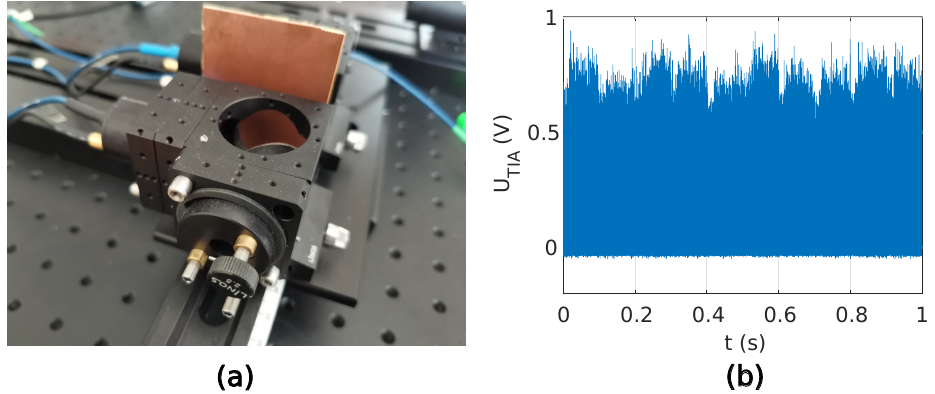
Figure 9. Experiment with obstructed THz beam path: ( a ) PCAs positioning with inserted copper plate, ( b ) section of the measured TIA’s output voltage.